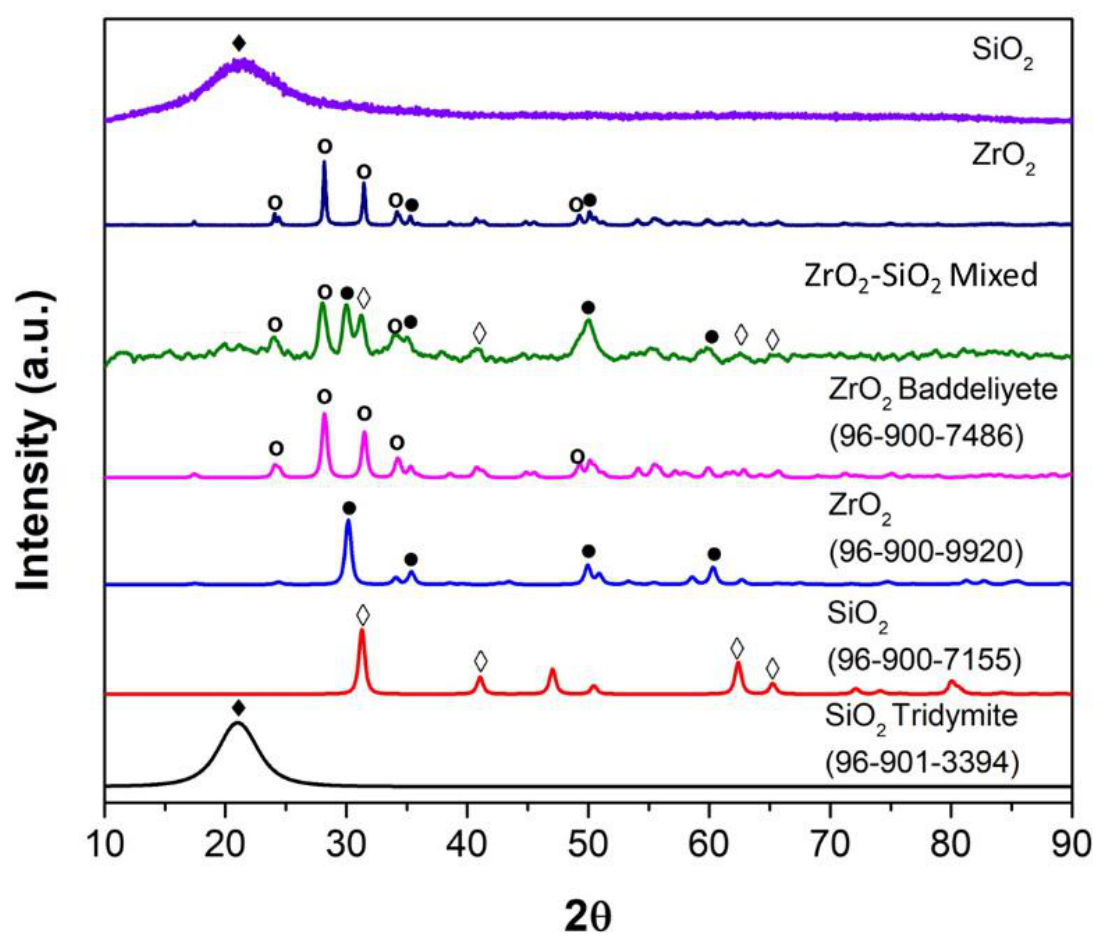
Figure 7. XRD Filler SiO 2 , ZrO 2 , and ZrO 2 -SiO 2 mixed. XRD spectra references are SiO 2 Tridymite/COD 96-900-7155 (solid square), SiO 2 Stishovite/COD 96-900-7155 (hollow square), ZrO